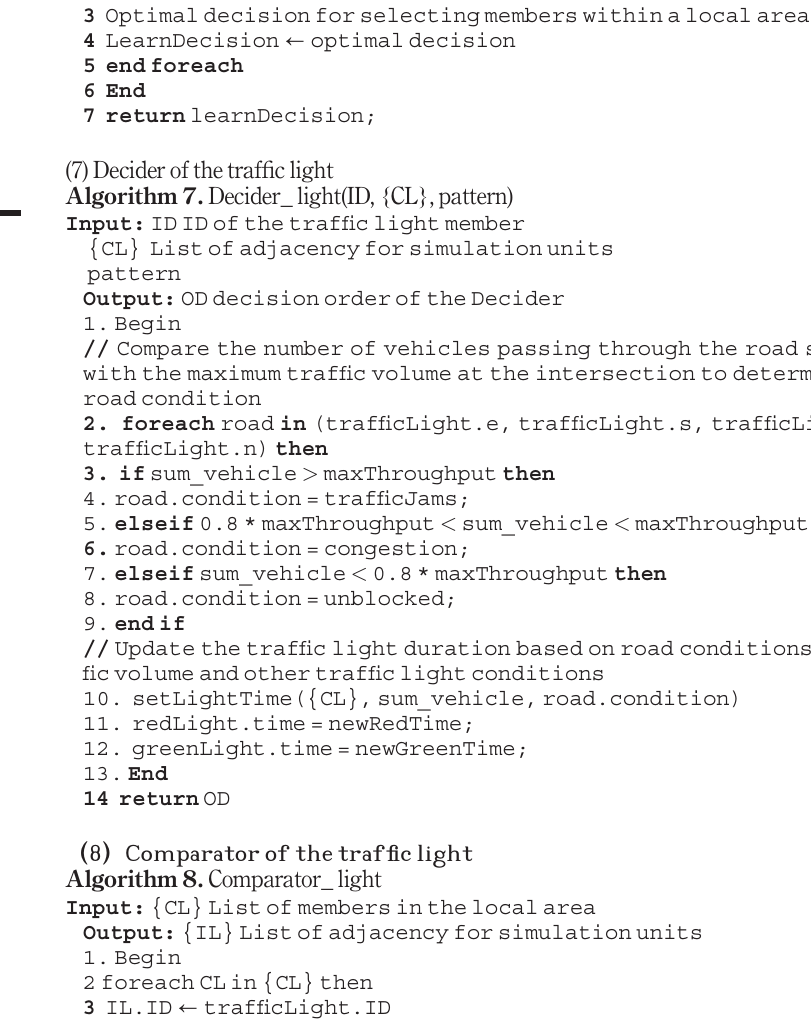
Algorithm 7. Decider_ light(ID, {CL}, pattern)